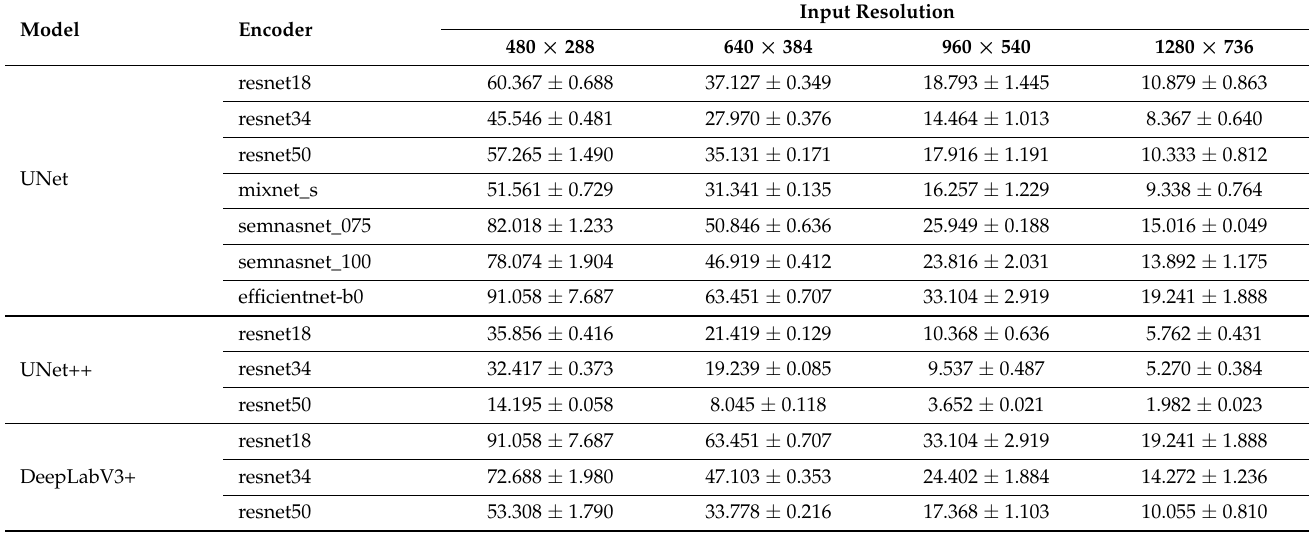
Table 2. One-batch inference speed (images per second) measurements of crowd-counting models for NVIDIA Jetson Xavier